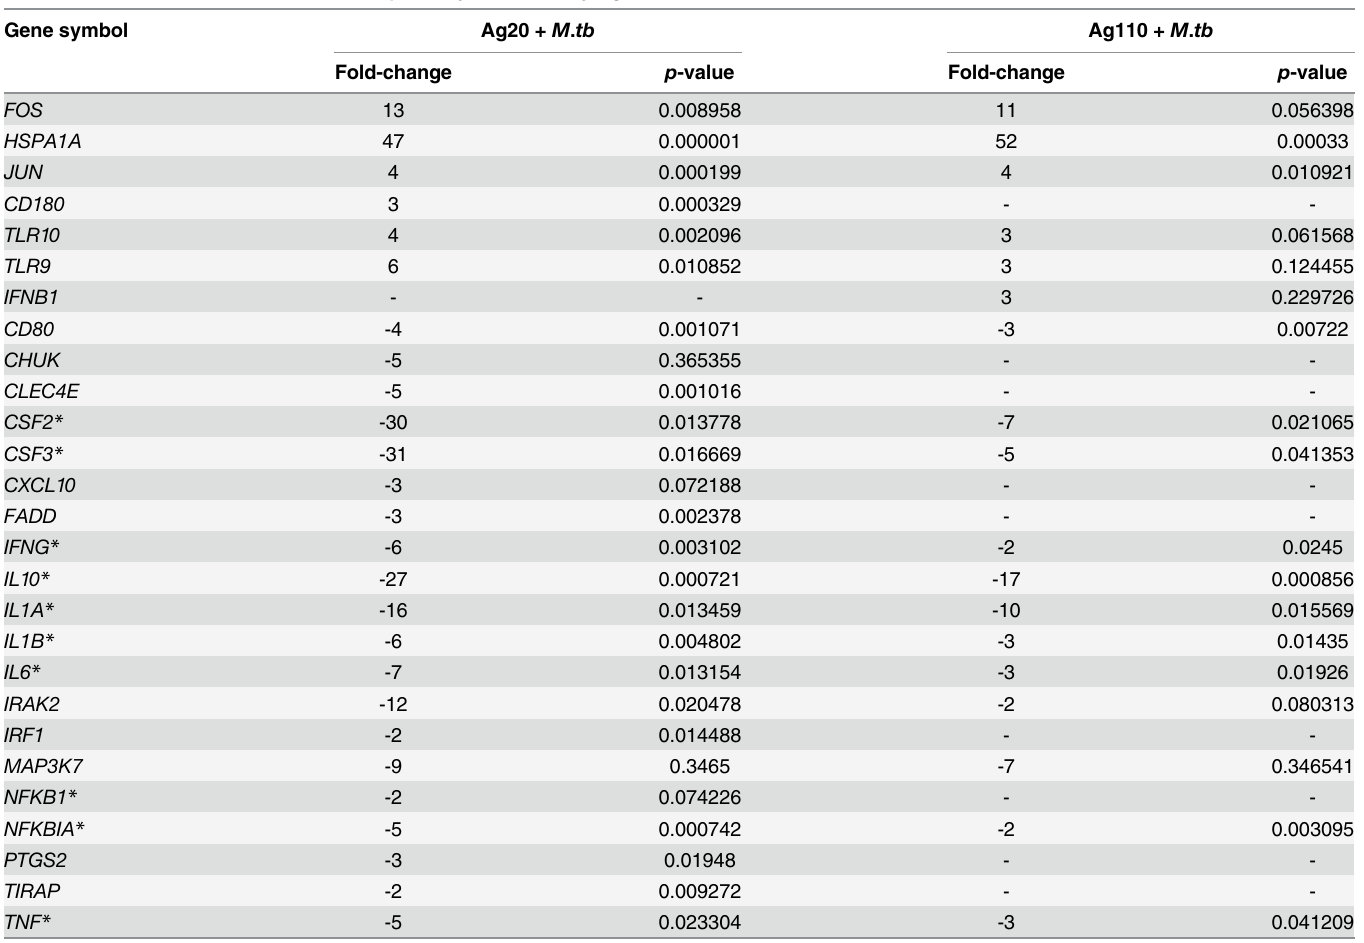
The abundance of TLR pathway-speci fi c mRNAs was compared in MDM exposed to Ag20-citrate + M . tb or Ag110-citrate + M . tb with that from MDM infected with M . tb only. Mean fold-changes of mRNA (cid:1) 2-fold and p -values relative to MDM infected with M . tb only are shown. The NF- κ B target genes are marked by an asterisk ( * ). The p -values are calculated based on a Student ’ s t-test of the replicate 2^(- Delta Ct) values for each gene in the M . tb - infected and each of the M . tb + AgNP-exposed